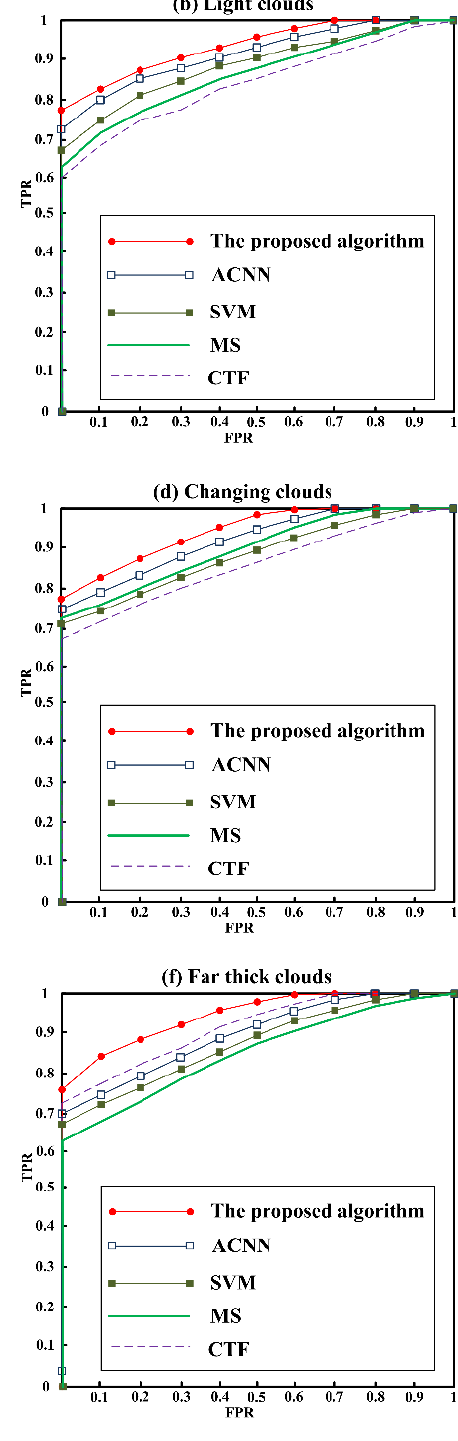
Figure 13. The ROC curve by different algorithm.